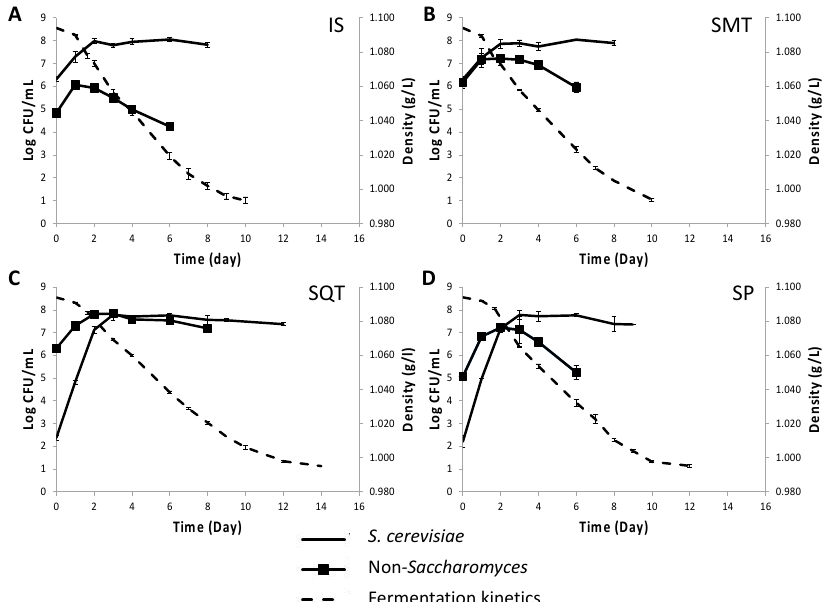
Figure 5. Kinetics of pilot-scale fermentations (dashed line) and yeast populations dynamics (con- tinuous line) in must inoculated with S. cerevisiae ScS13 ( A ), simultaneously inoculated T. delbrueckii TdS6 and S. cerevisiae ScS13 ( B ), sequential inoculated T. delbrueckii TdS6 and S. cerevisiae ScS13 ( C ) and in non-inoculated must ( D ). ESA medium was used for enumeration for enumeration S. cerevisiae (-) and LA medium for non- Saccharomyces yeasts ( ■ ).